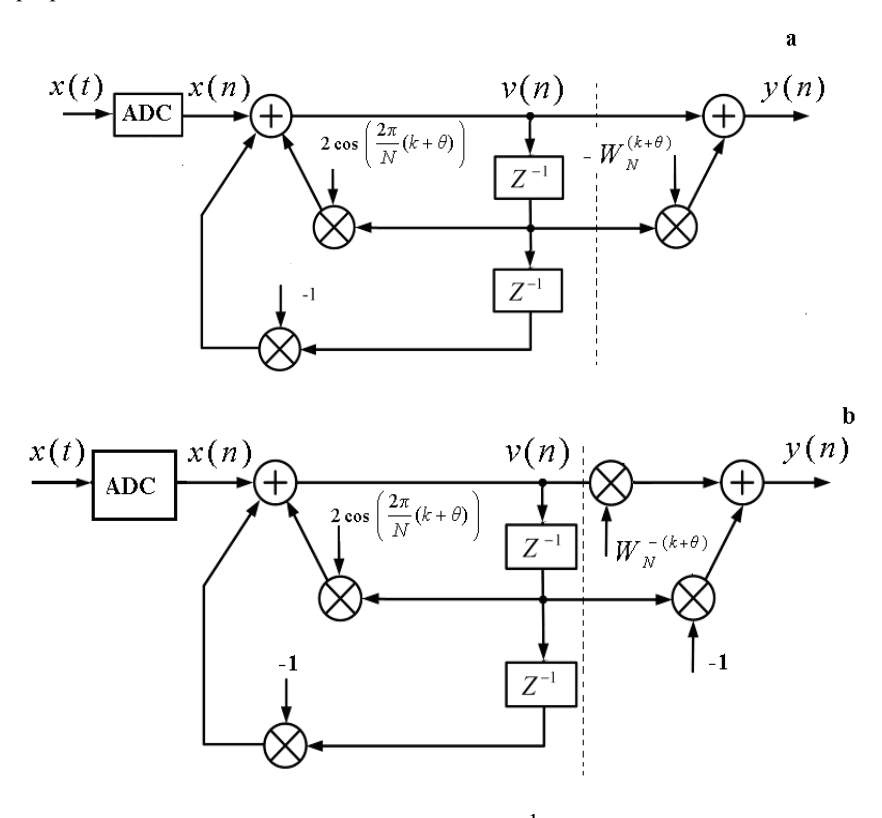
Fig. 1. IIR filter structures that implement the generalized Goertzel algorithm at the )(  k frequency at 10